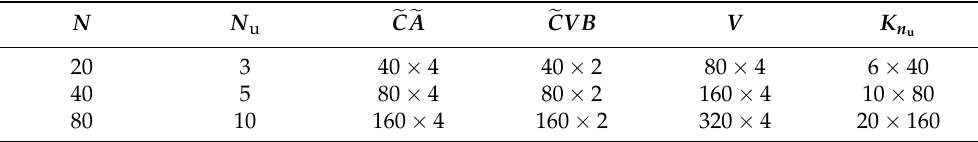
Table 2. Size of matrices used in MPC for different prediction and control horizons.